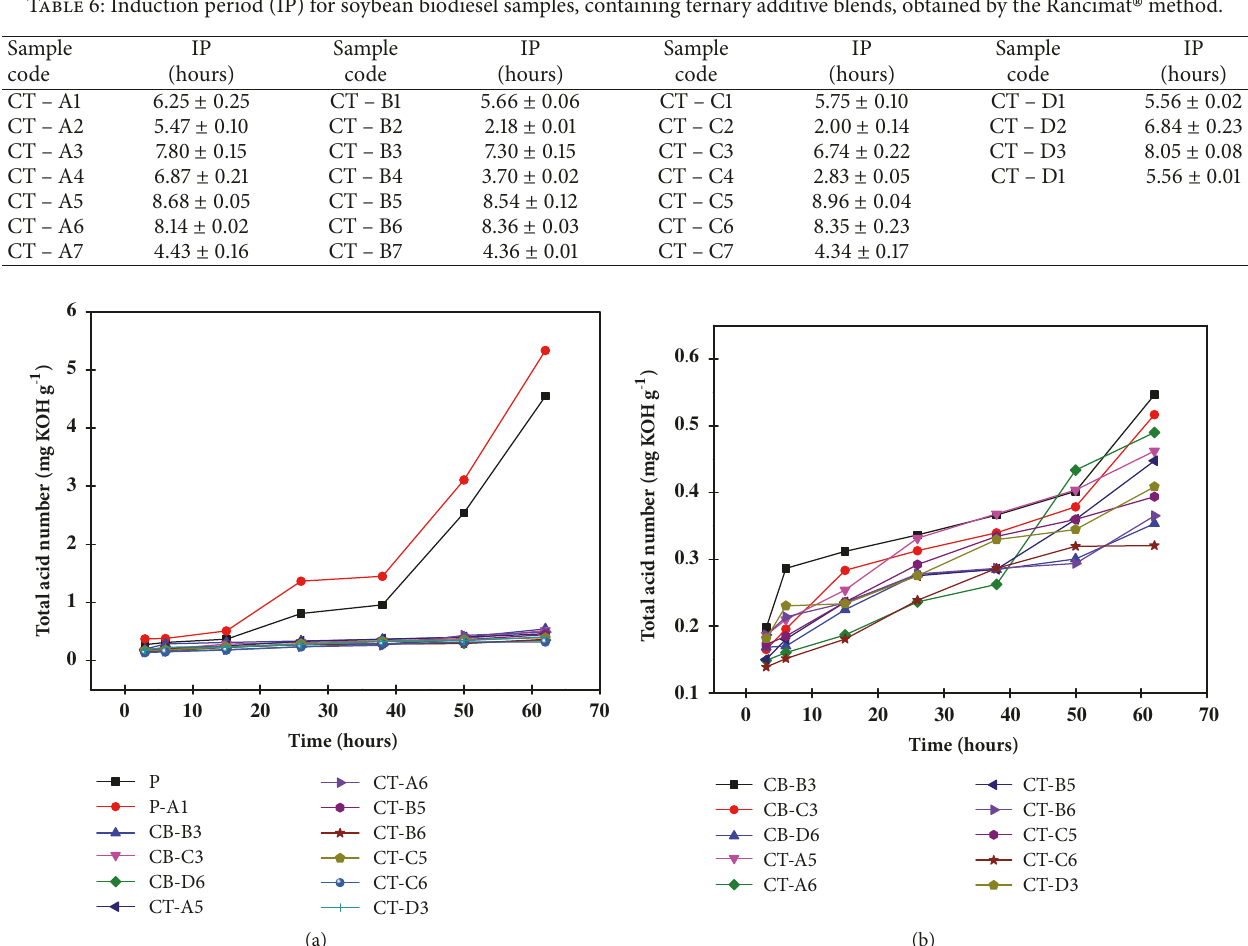
Table 6: Induction period (IP) for soybean biodiesel samples, containing ternary additive blends, obtained by the Rancimat (cid:2) method.